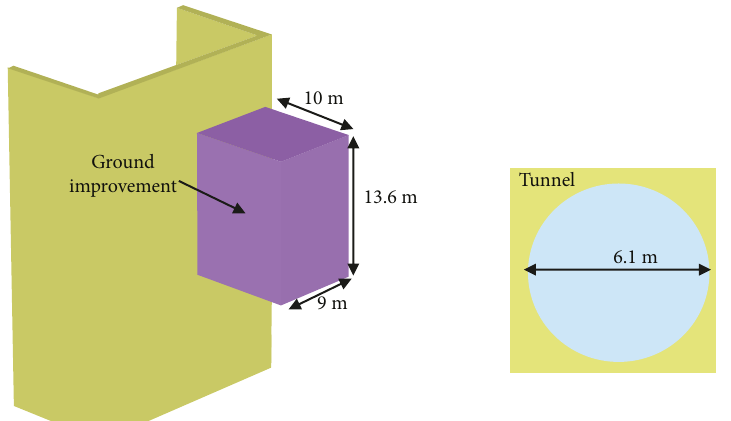
Figure 4: Details of tunnel eye and soil improvement zone in the model.